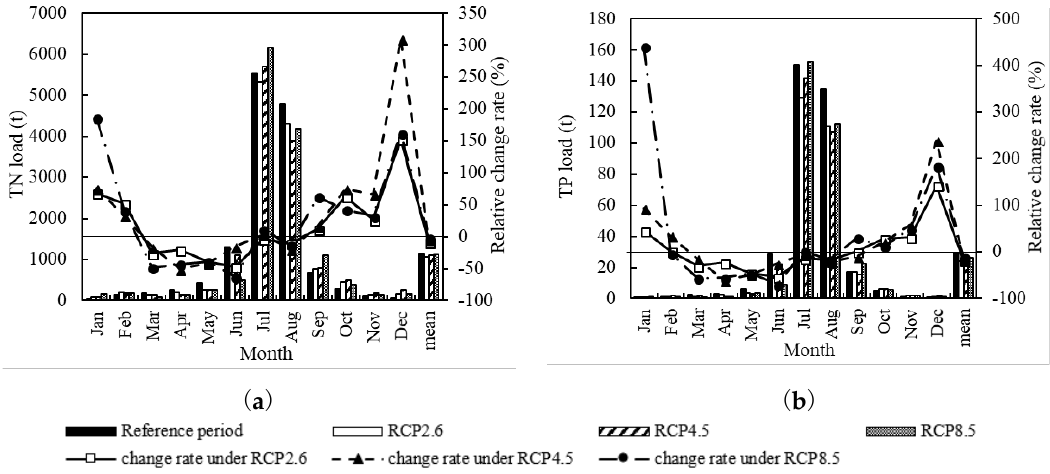
Figure 9. Monthly TN load change ( a ) and TP load change ( b ) under the Future Climate Change scenario.